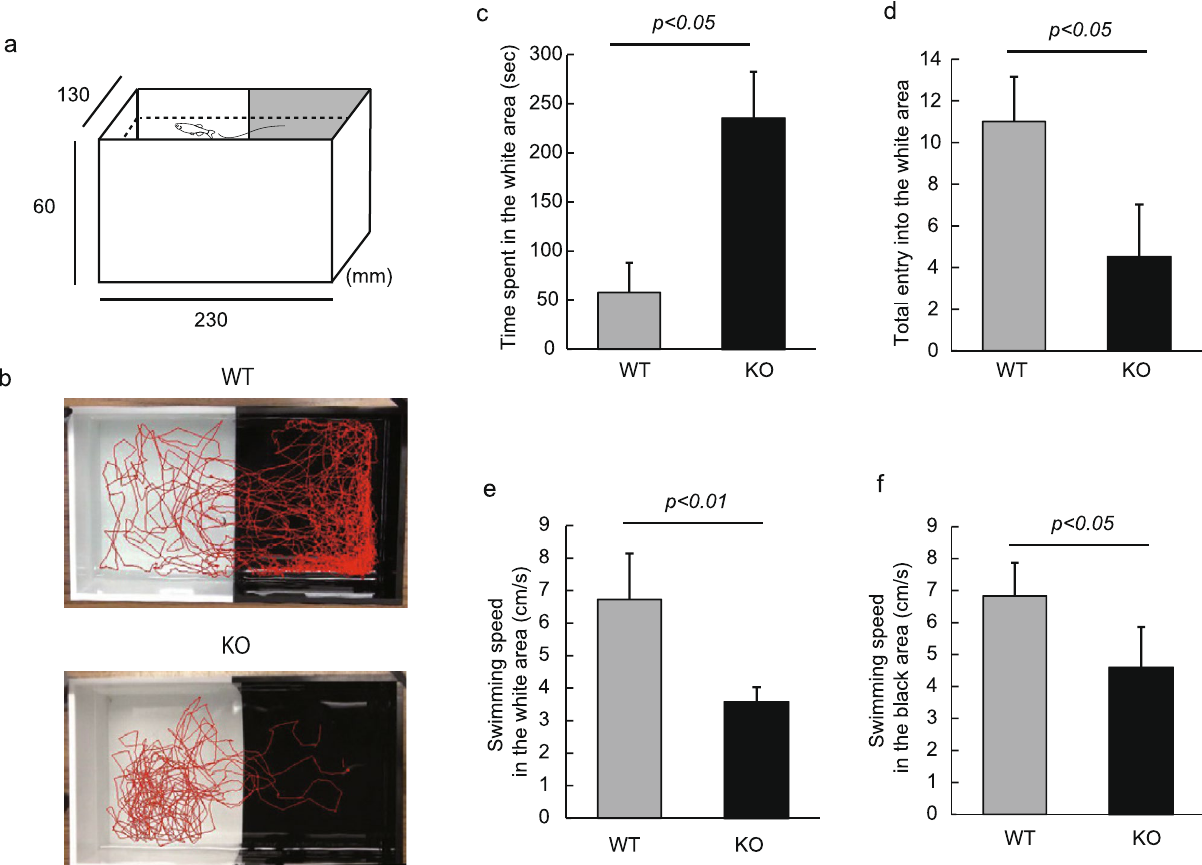
Figure 5. Analysis of the black–white preference test in Neu1-KO and WT zebrafish. ( a ) Apparatus in the black–white preference test. ( b ) Tracking of WT (upper panel) and Neu1-KO zebrafish behavior (lower panel). ( c ) Time spent in the white area. ( d ) Total entry into the white area. ( e , f ) Swimming speed in white ( e ) and black area ( f ). n = 5 for each group. Results are shown as means ± standard deviation. All values were compared using Mann–Whitney U